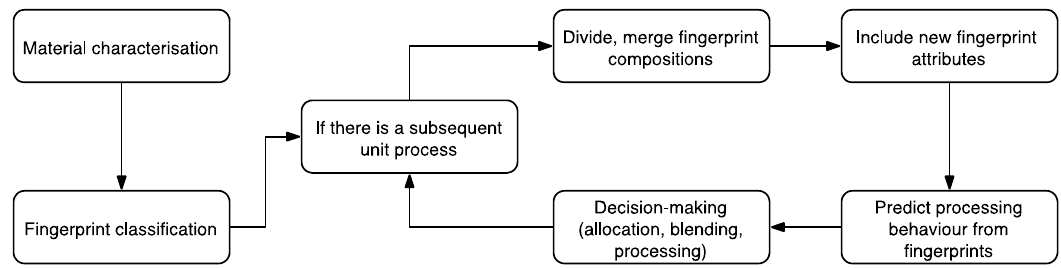
Figure 5. Flowsheet on how the hybrid fingerprint character allows for changes in the fingerprint composition during the unit processes of a mine and allows for better decision-making.